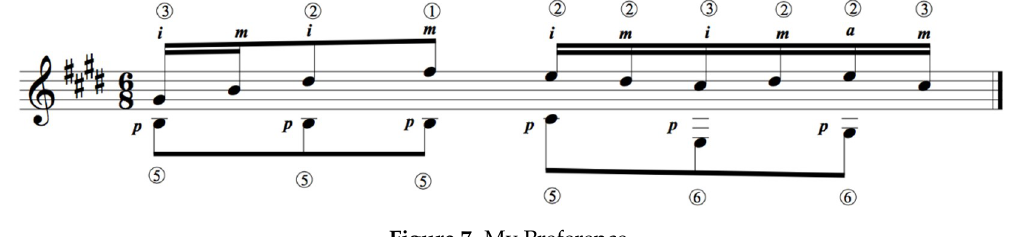
Figure 7. My Preference.